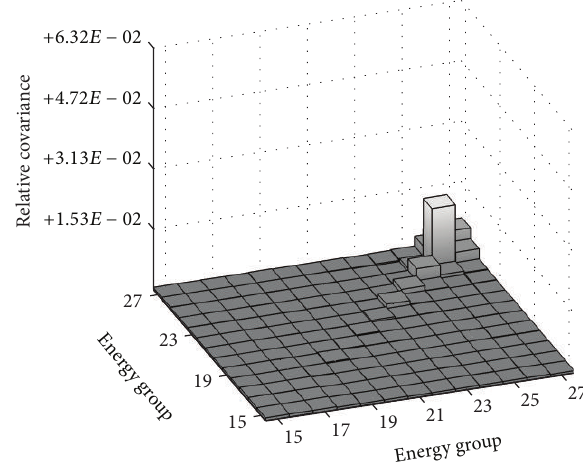
Figure 22: 𝜎 U 235 𝑓 covariance at 𝜎 0 = 200𝑏 .